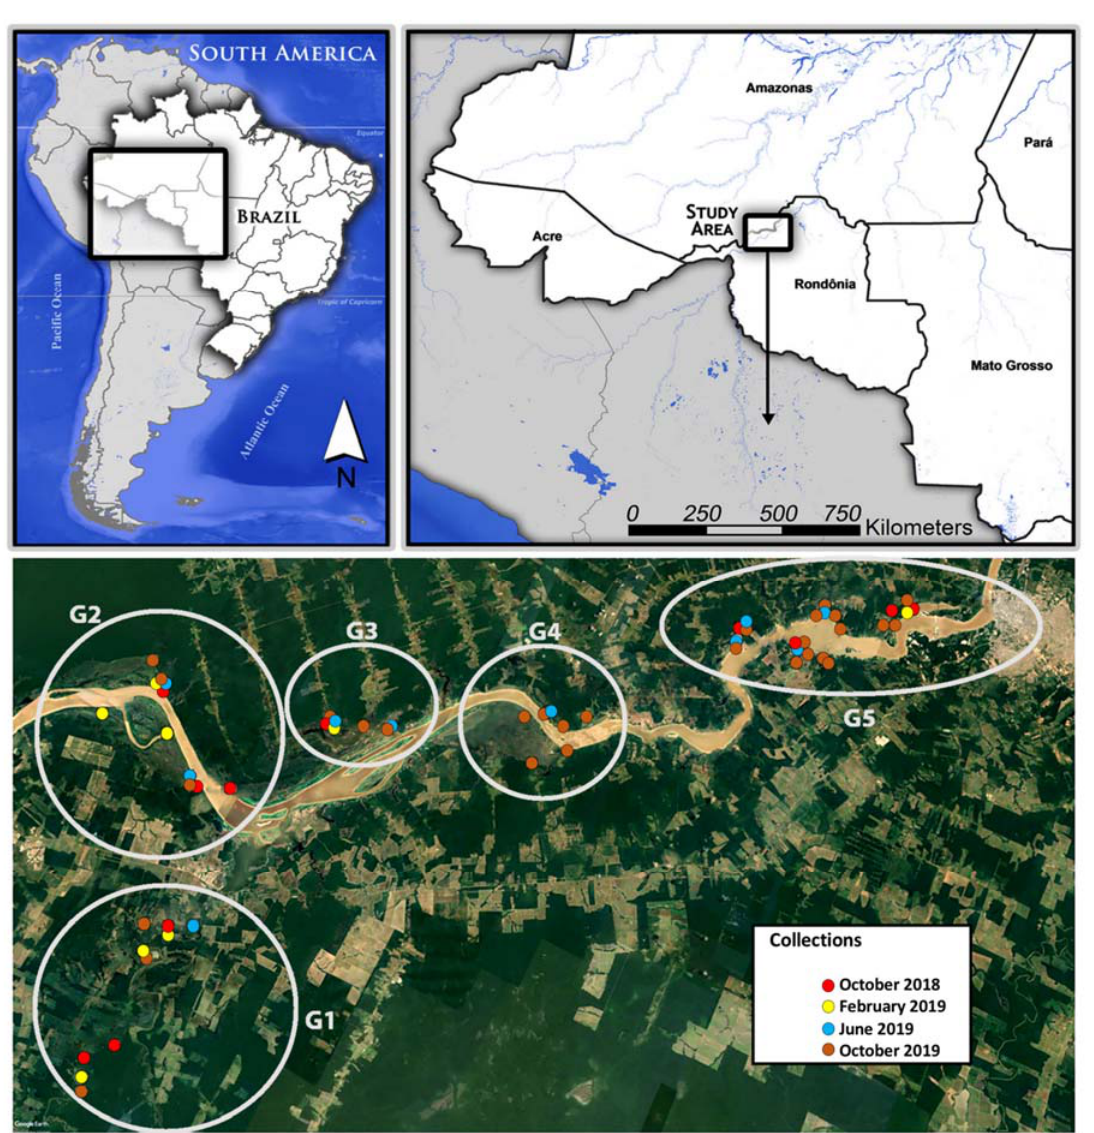
Figure 1. Distribution of the water collection sites along the margins and vicinities of the Madeira River, Porto Velho, State of Rondônia, Brazil. Different colors represent different collection periods, the gray circles highlight five groupings of water samples according to their geographic proximity.